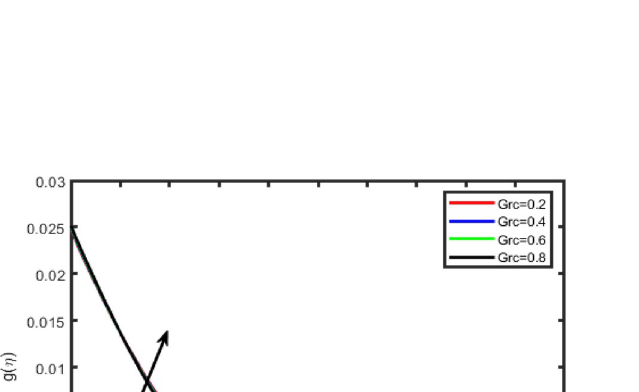
Figure 14. Effect of mass Grashof number (Grc) on tangential velocity f ′ (η).